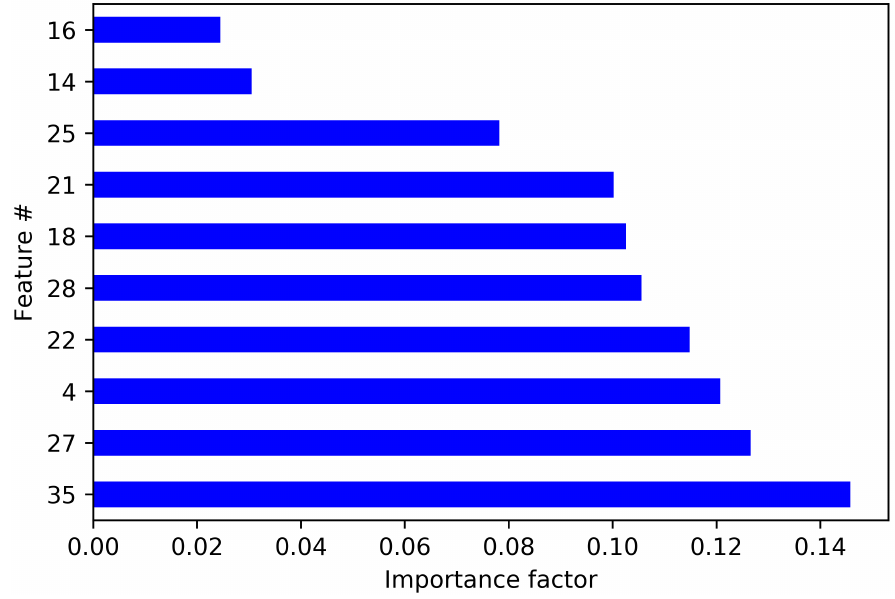
Figure 2. Top 10 high importance features for the second stage ML model. Table 6. Performance of feature selection methods for the second stage ML